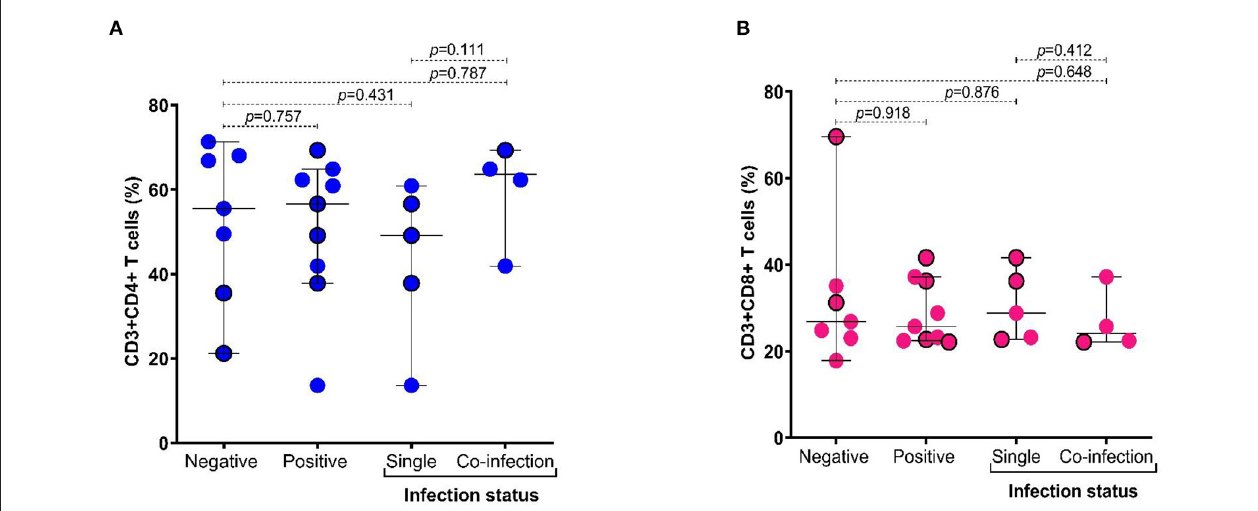
FIGURE 5 | Distribution of frequency of CD4 + and CD8 + T cells according to infection status by intestinal protozoa. (A) Frequency of CD3 + and CD4 + T cells (%); (B) frequency of CD3 + and CD8 + T cells (%). Bars represent the median with the P 5 -P 95 range. The circles with borders represent patients without pharmacological therapy. Statistical analyses were performed by Mann–Whitney U test. Significance was set at p <